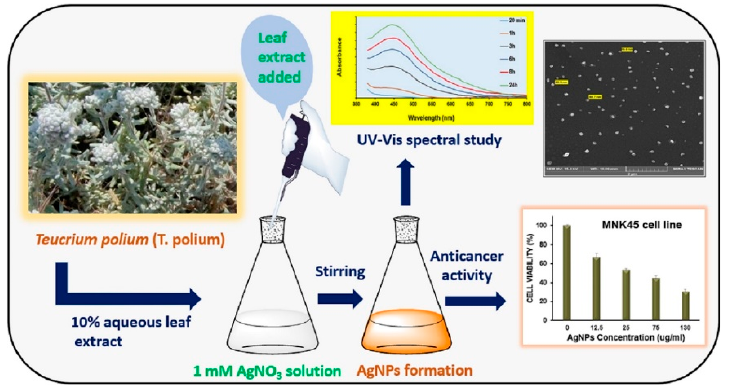
Figure 14 . Leaf extract and synthesized nanoparticles of medicinal plant poliomyelitis and their anticancer activity. Reprinted/adapted with permission from Ref. [85]. Copyright 2020, Elsevier.